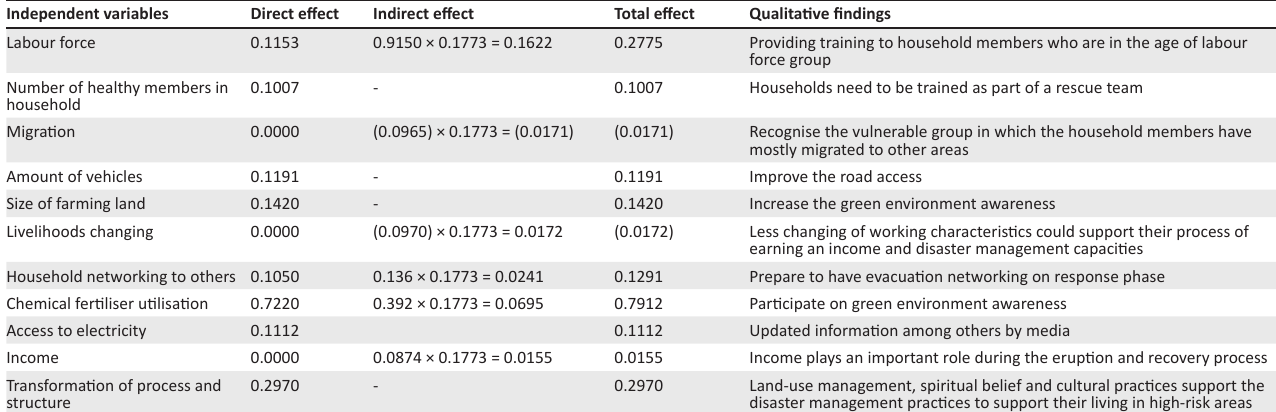
TABLE 2: Total effect of factors influencing disaster management and the qualitative findings. Independent